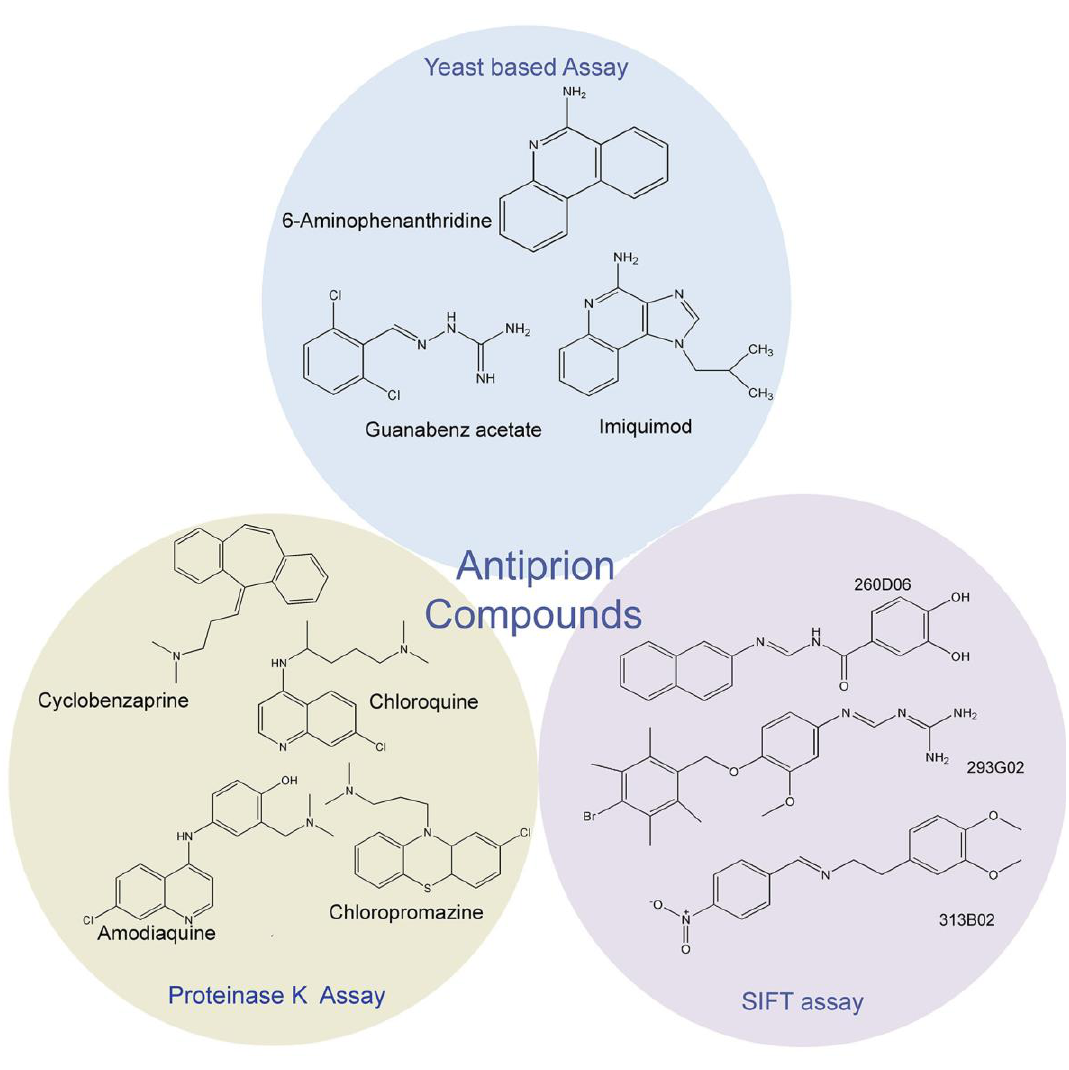
Figure 1. Antiprion compounds identified by different screening assays. Only compounds representing different chemical groups are included here. Antiprion compounds formed by chemical substitutions of these chemical groups are not included, due to space